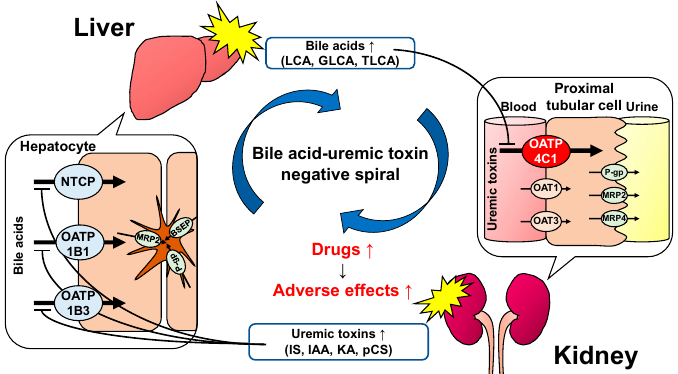
Figure 5. Hypothetical scheme of the “bile acid–uremic toxin negative spiral”. OATP4C1 inhibition by bile acids causes the accumulation of uremic toxins, which may inhibit the bile acid uptake into hepatocytes via NTCP and OATPs. Further accumulation of uremic toxins and bile acids may be induced by the inhibition of OATP4C1 and hepatic bile acid transporters.